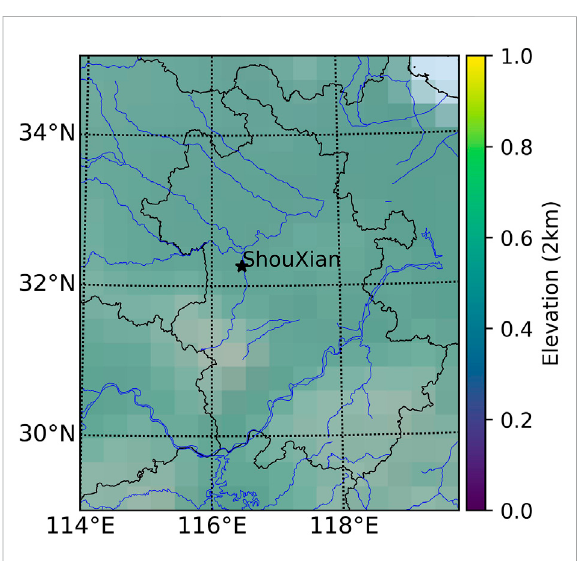
FIGURE 1 The location of the observation point. The black asterisk in the fi gure refers to